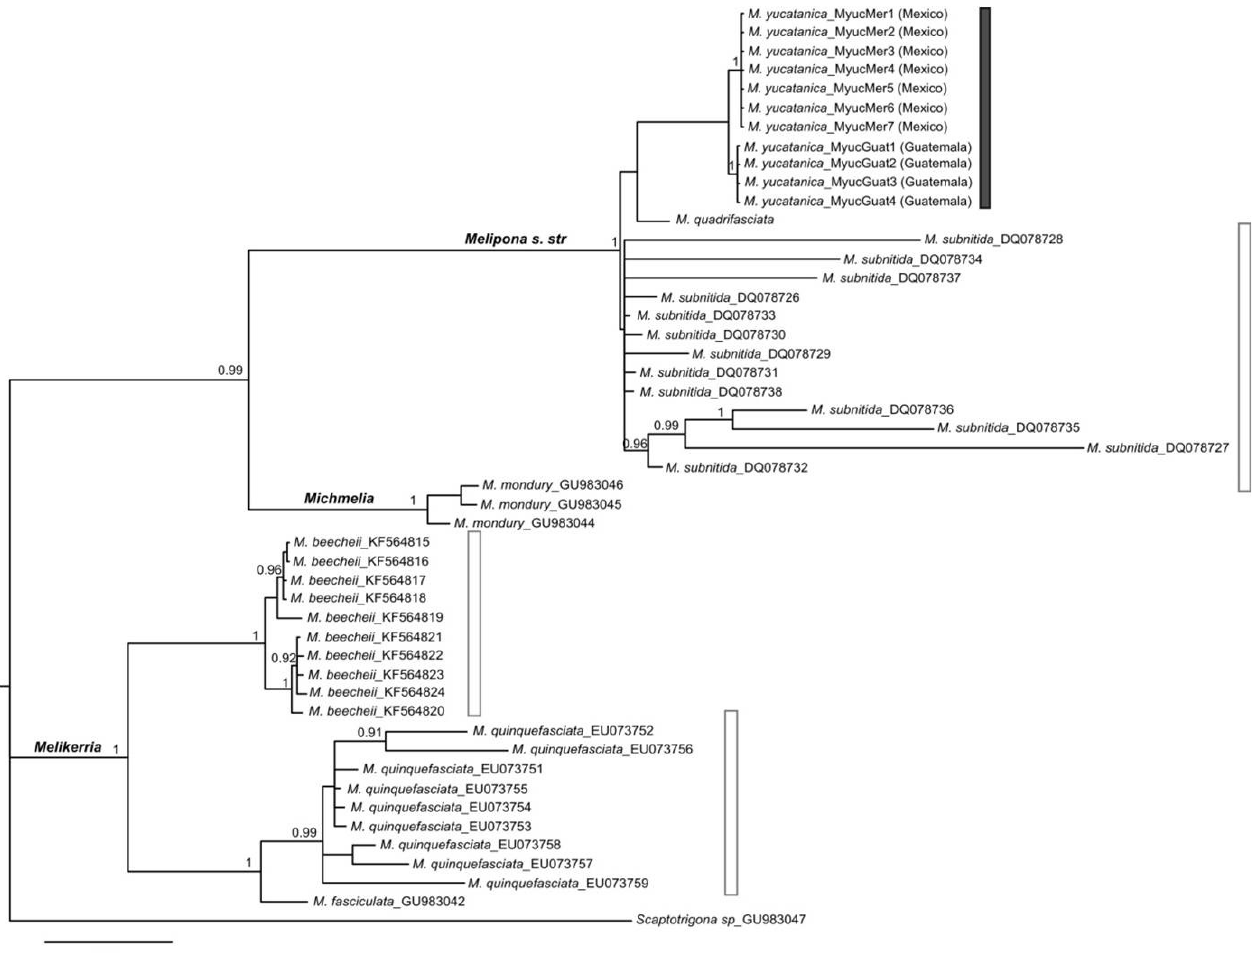
Fig 2 . Bayesian analyses of the ITS1- complete region of several Melipona species. Population data of Melipona yucatanica are indicated with a solid bar. Available population data of several Melipona species are indicated with empty bars. Numbers above nodes show posterior probability ≥